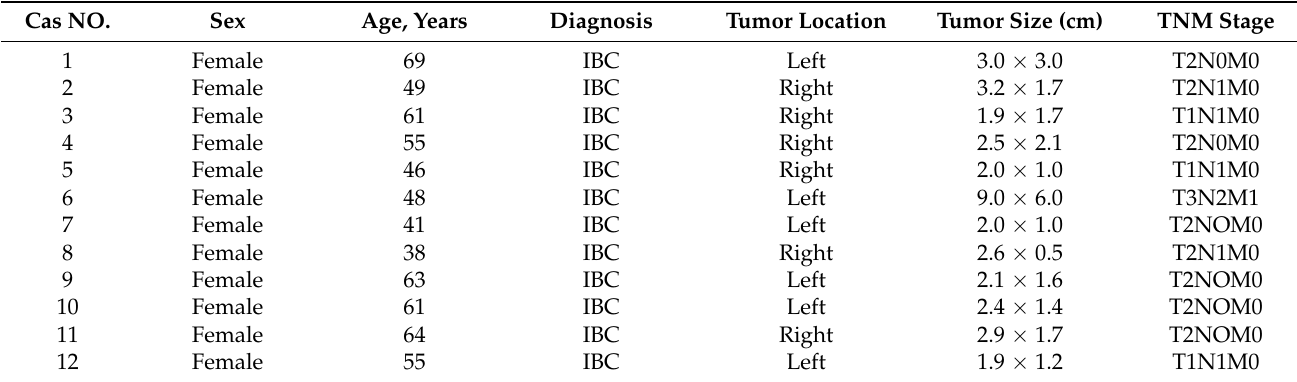
Table 2. Clinicopathological Characteristics of BC